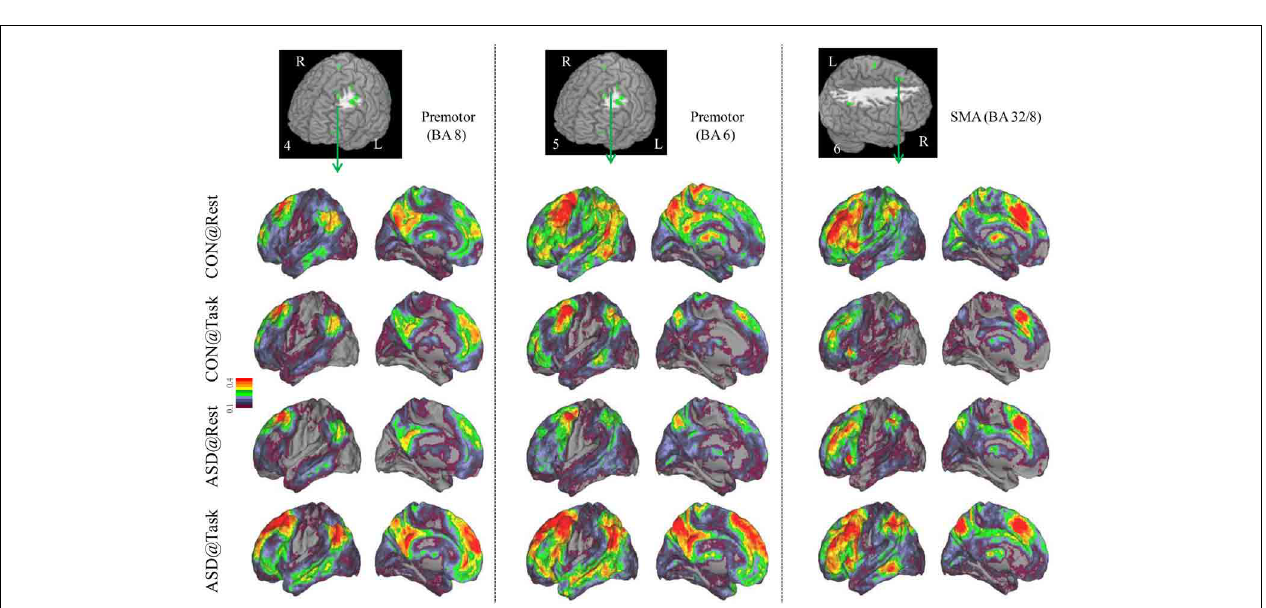
FIGURE 2 | Seed-based connectivity maps of distant functional connectivity patterns in resting and task states, for three clusters showing Group × Task interaction: left orbital frontal gyrus (BA 11) (left